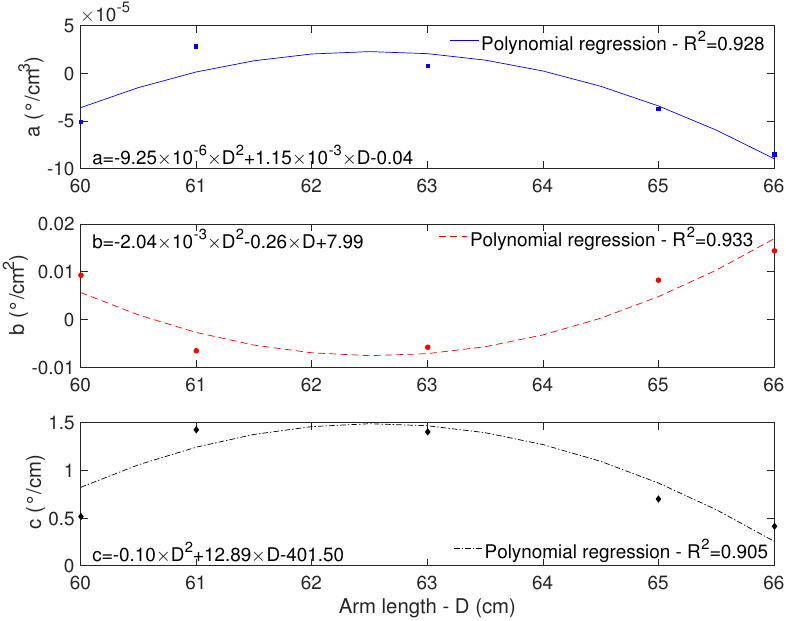
Figure 13. Polynomial regression between the subjects’ arm length (parameter D) and the coefficients of angular error